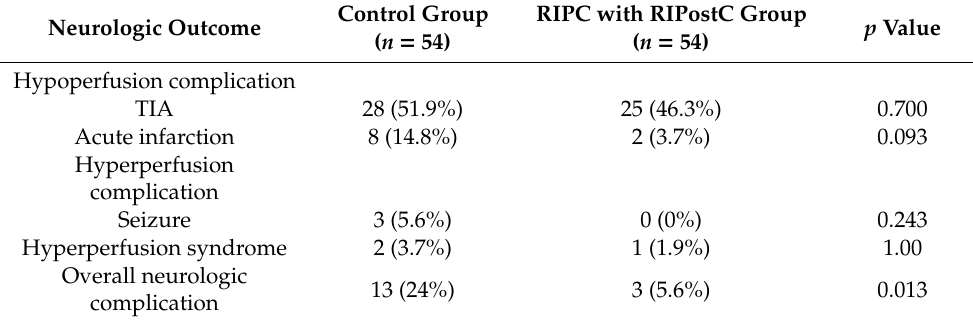
Table 3. Neurologic